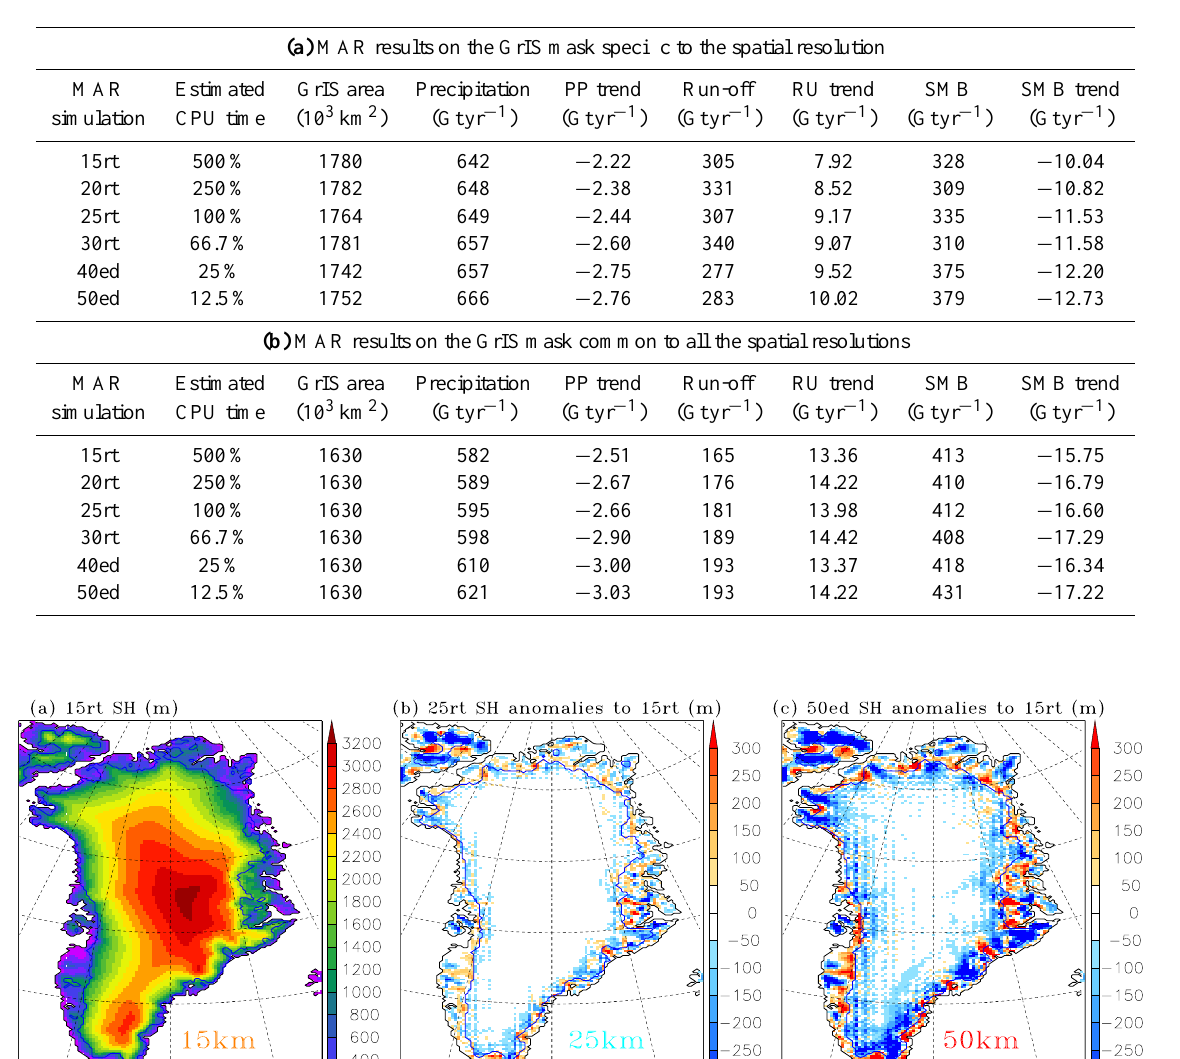
Table 2. (a) Annual GrIS SMB components simulated by MAR at 15–50km resolution for the 1990–2010 period on the ice sheet mask specific to each spatial resolution. (b) The same as (a) , but on the ice sheet mask common to all the spatial resolutions.